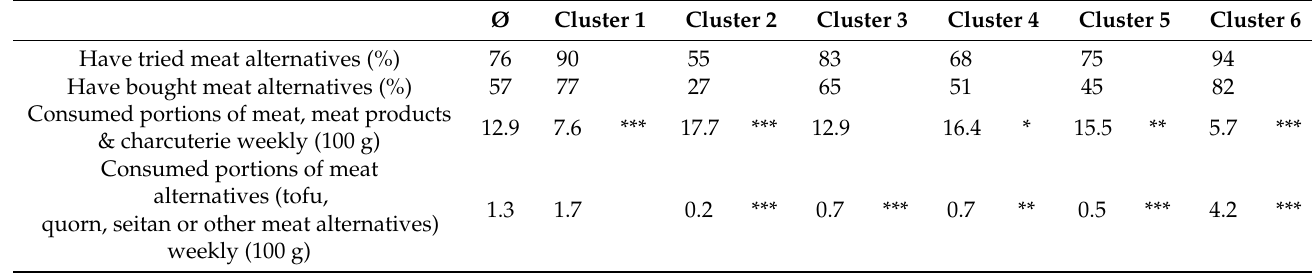
Table 5. Comparison of clusters with regard to respondents’ experiences with and consumption of meat and meat alternatives.